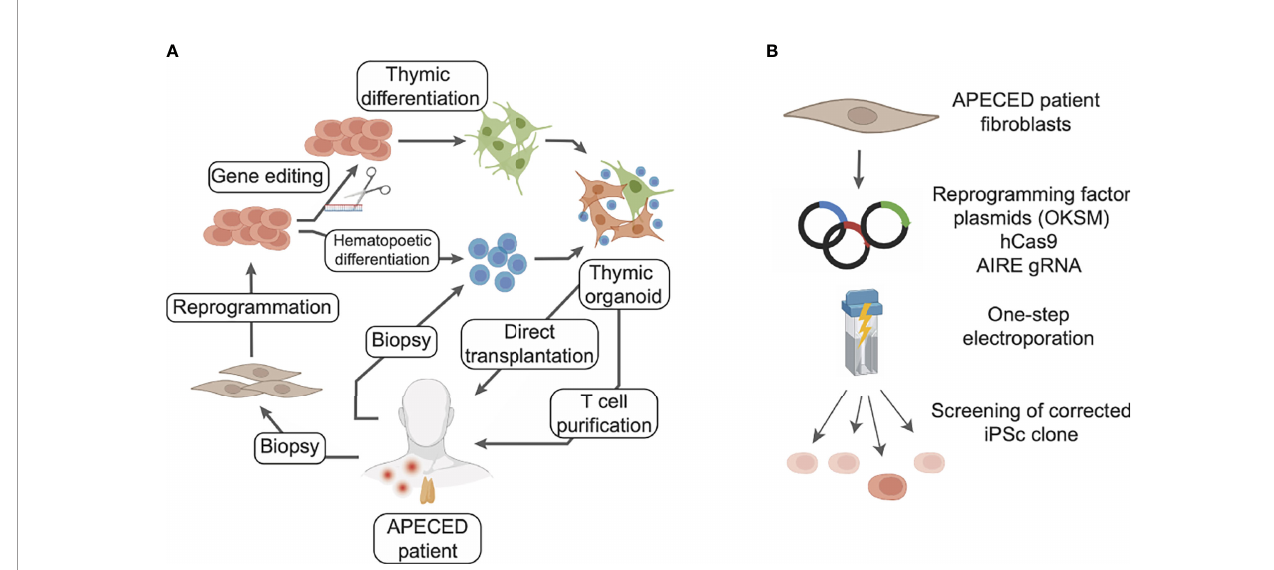
FIGURE 4 | Potential cellular therapy strategies for treating APECED with induced TECs to restore thymic functionality. (A) Fibroblasts from the patient can be reprogrammed to iPSc and the defective gene corrected with gene editing tools. Differentiation of these iPSc into thymic epithelial cells, in combination with T cell progenitors differentiated from the same iPSc or directly puri fi ed from patient blood, would allow generation of arti fi cial thymic organoids. These organoids could be either directly transplanted or used to generate competent T cells ex vivo to reconstitute the patient immune system. In this scenario T cell progenitors could be puri fi ed from patient blood or differentiated from patient iPSc. (B) Gene editing of a de fi cient gene from a patient can rely on CRISPR/Cas9 and be combined with reprogramming steps for the obtention of